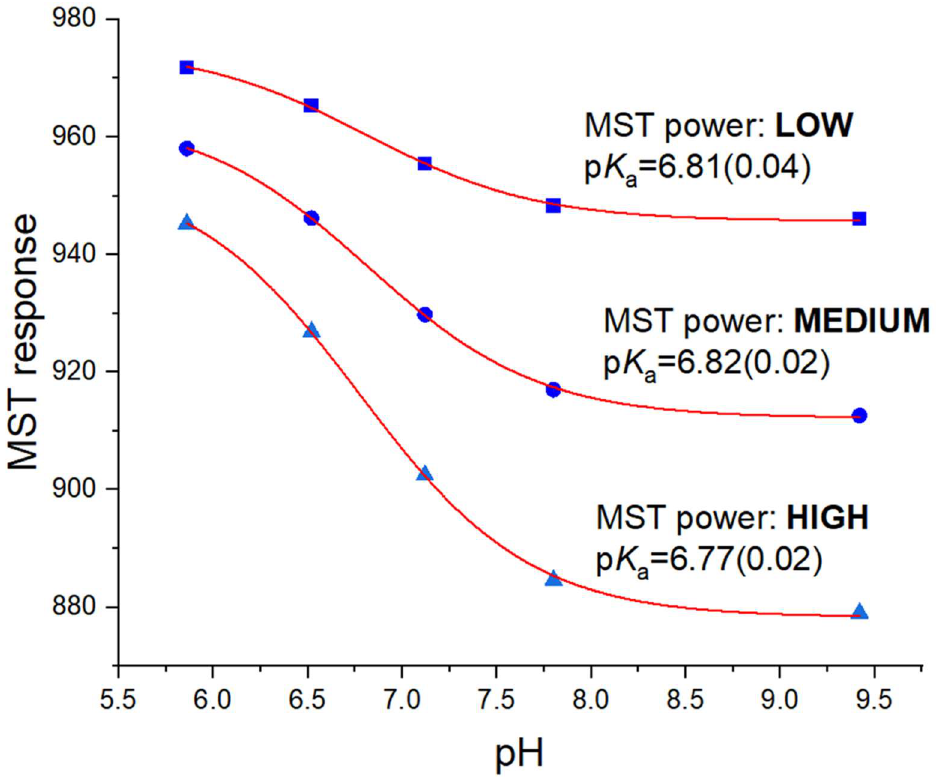
Figure 3. MST response as a function of pH at three IR laser powers, with non-linear fit and determined p K a values. The error of p K a determination is given in parentheses as the model fit error predicted by the Origin Pro 2020 software.